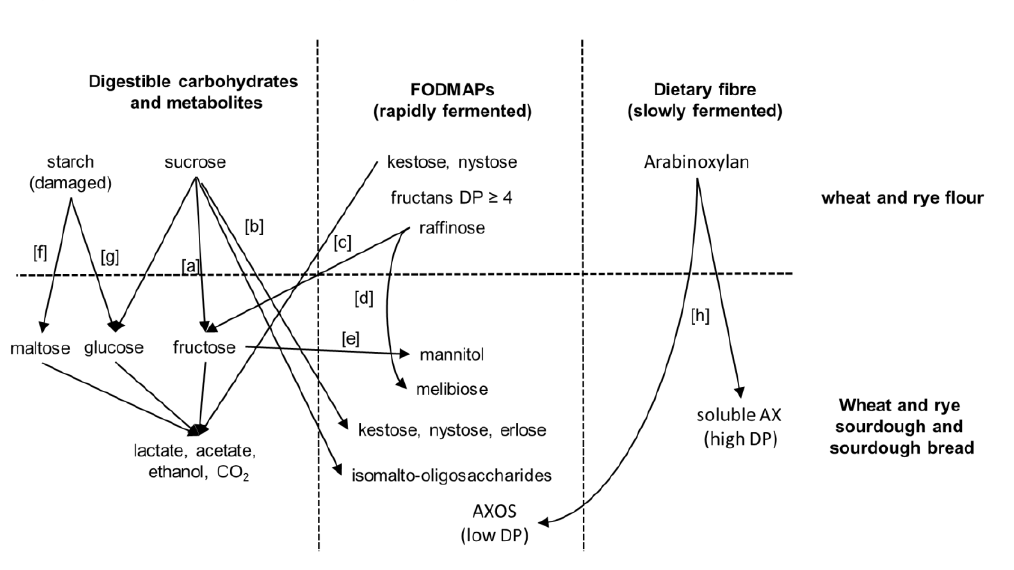
Figure 1. Conversion and generation of fermentable oligosaccharides, disaccharides, monosaccharides, and polyols (FODMAPs) in wheat and rye sourdoughs. Sucrose hydrolysis by yeast invertase or fructosidases of lactic acid bacteria [a]. Oligosaccharide formation by glucansucrases to form isomalto-oligosaccharides, or by fructansucrases to form kestose, nystose, and erlose from sucrose [b]. Kestose and nystose degradation by yeast invertase or by intracellular (phospho)-fructosidases of lactic acid bacteria [c]. Raffinose conversion by yeast invertase and levansucrase from lactic acid bacteria [d]. Fructose conversion by mannitol-dehydrogenase from heterofermentative lactic acid bacteria [e]. Starch conversion to maltose and glucose by flour amylases and gluco-amylase [f,g]. Exogenous xylanases are used in baking to increase the amount of soluble pentosane (arabinoxylan, AX) to improve bread properties, which can produce low DP arabinoxylan oligosaccharides (AXOS) along soluble high-DP arabinoxylan fragments [h].